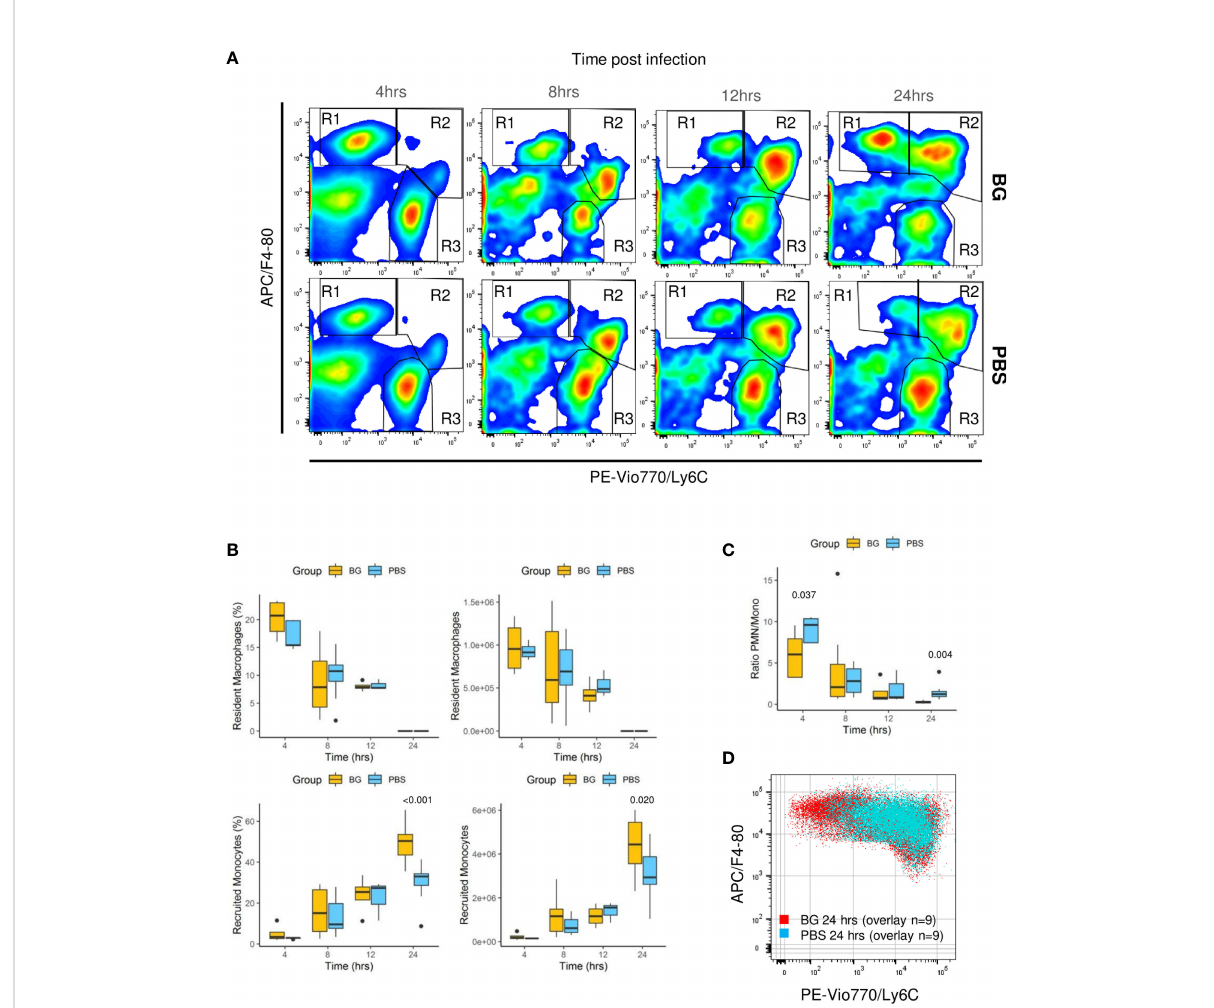
FIGURE 6 Flow-cytometry analysis of F4-80 + subpopulations from peritoneal exudates collected throughout the infection. (A) Representative fl ow- cytometry panels of F4-80 pos /Ly6C pos cell distributions over time in each experimental group. (B) Frequencies and numbers of F4-80 high Ly6C low resident peritoneal macrophages or F4-80 low Ly6C high recruited in fl ammatory monocytes. (C) Ratio of PMN over recruited monocyte numbers over time. (D) Overlay of F4-80 pos /Ly6C cells from nine b -glucan-supplemented mice and nine PBS control mice at 24 h p.i. Statistical analysis was performed using the Welch t-test and signi fi cant p values are indicated. The number of mice and experiments are detailed in Supplementary Table